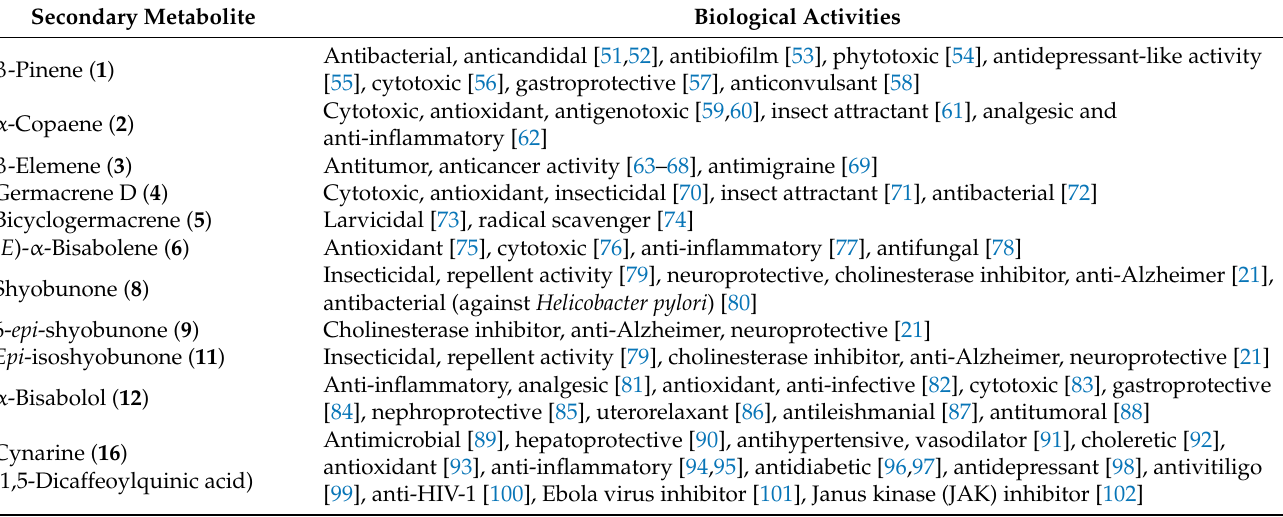
Table 6. Biological activities of the compounds identified in the fruit essential oil, fruit, and root methanol extracts of Ferula drudeana